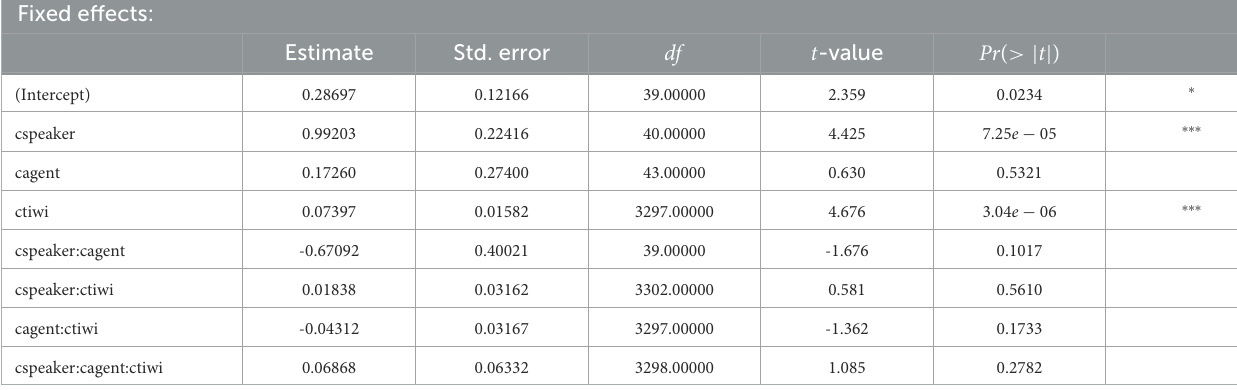
TABLE 6 Coefficients, SE s, df s, t -values, and p -values for the optimal model of logratios of target fixations for the NP2 time window in Experiment 3.